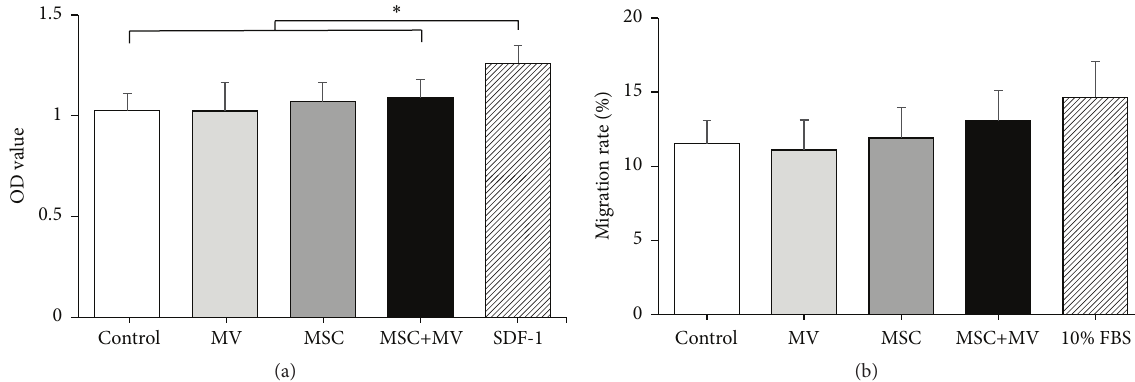
Figure 6: The effects of MSC-MVs on the endothelial adherence and migration of the expanded CD34 + cells. (a) The expanded cells were seeded on a monolayer of HUVECs, and the number of adherent cells was determined by MTT assay. Five replicated wells were set up for each group, SDF-1 served as positive control, ∗ 𝑃 < 0.05 . (b) The migration abilities of the expanded cells were assessed by a transwell assay. Three replicated wells were set up for each group; 10% FBS served as positive